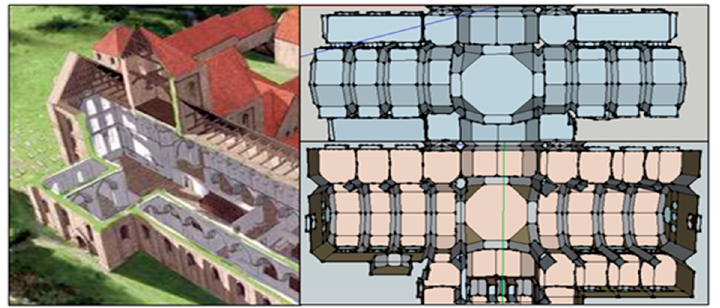
Figure 3. Illustration by Peter Urmston of the Roche Abbey Tower ( left ) was used as an architectural reference to model the Beaulieu Abbey Tower ( right ) [8].